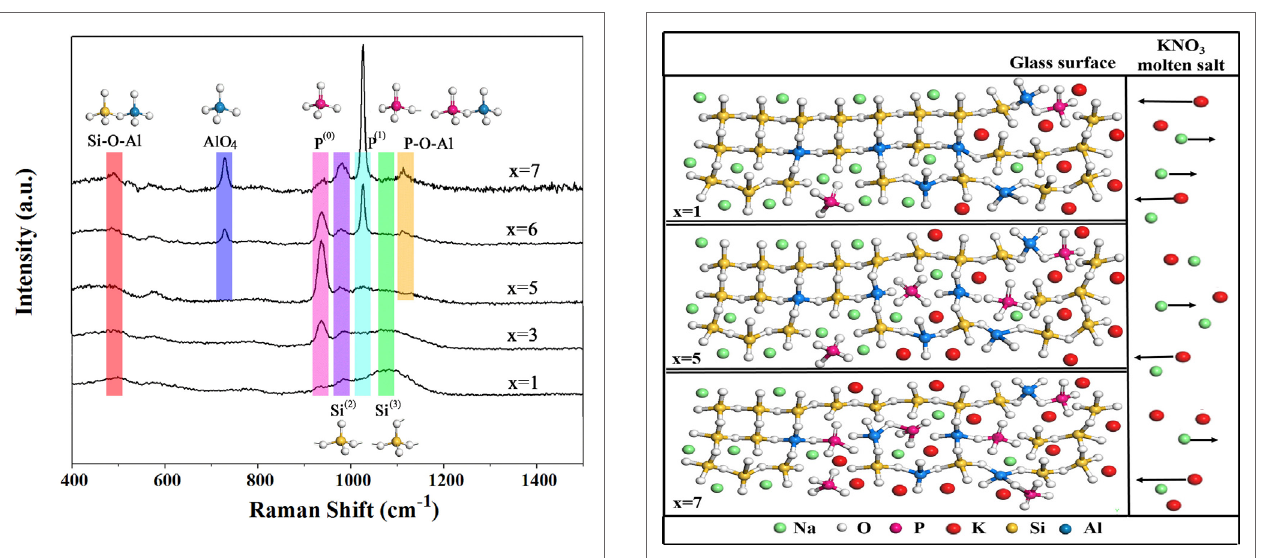
surface at various concentrations of P 2 O 5 ( x = 1, 5, and 7 mol%) treated at 400°c for 6 h